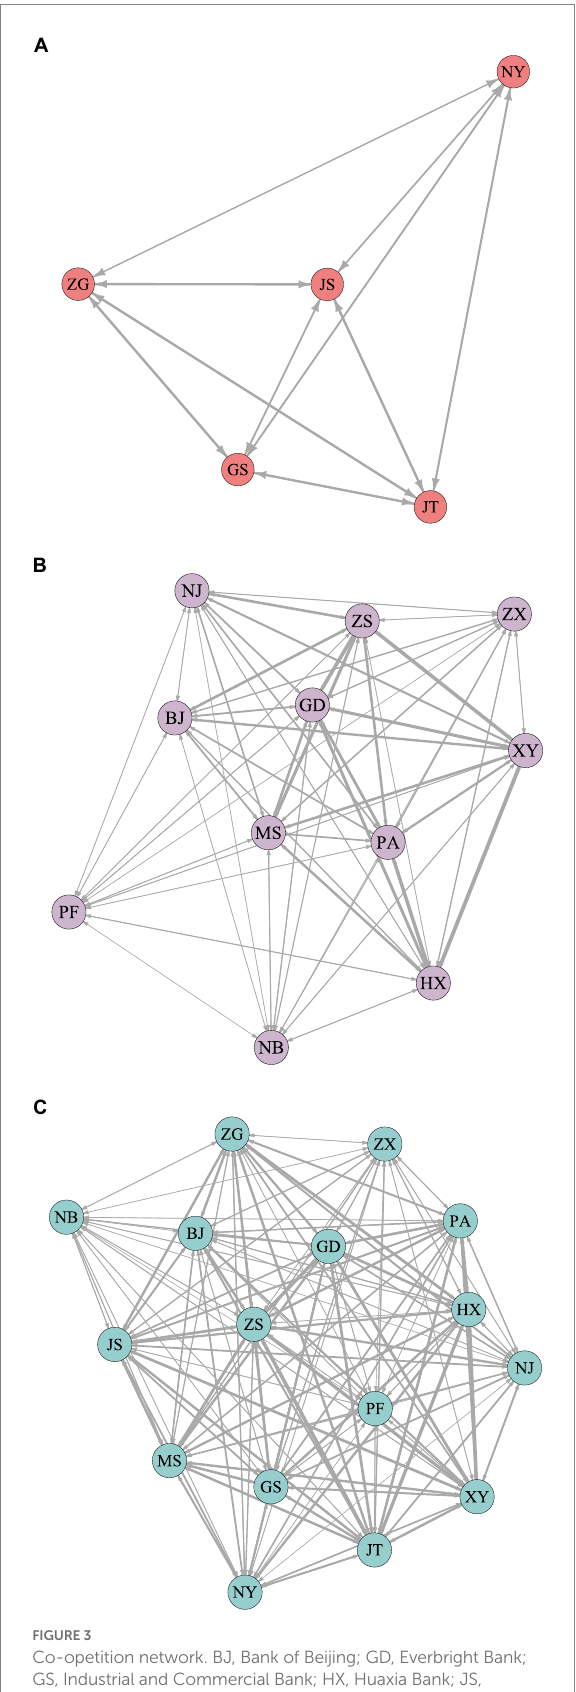
FIGURE 3 Co-opetition network. BJ, Bank of Beijing; GD, Everbright Bank; GS, Industrial and Commercial Bank; HX, Huaxia Bank;